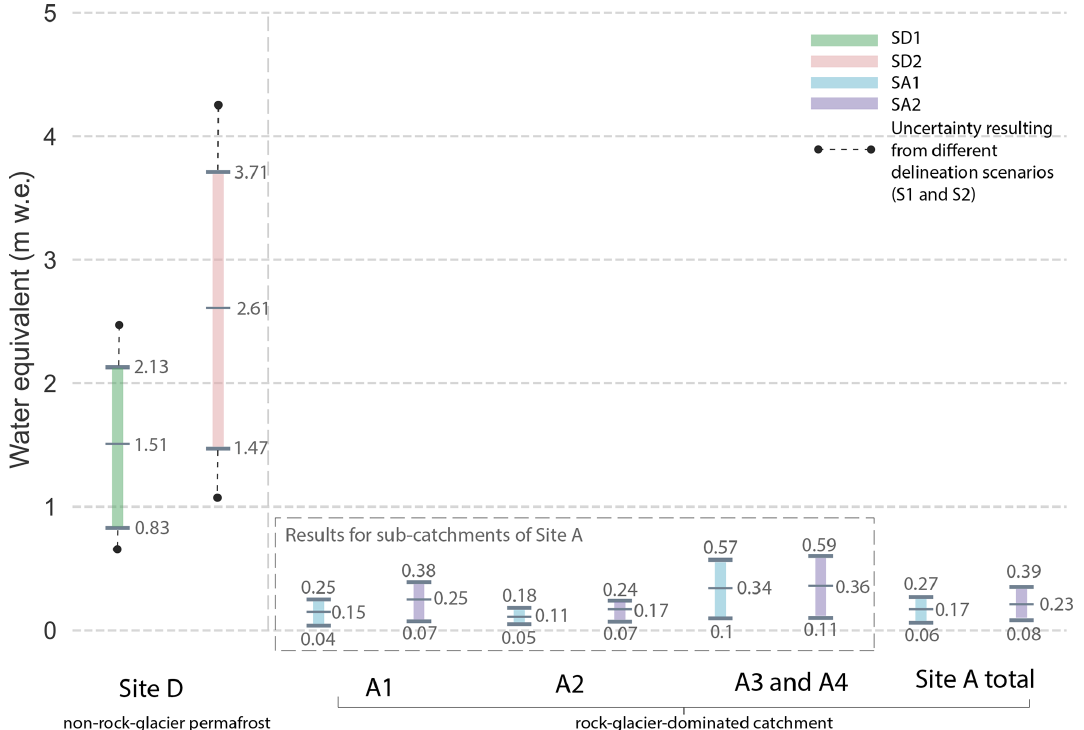
Figure 8. Calculated minimum, mean, and maximum water equivalents (mw.e.) for the different scenarios (SD1–SA2), as well as for rock glaciers and talus slopes, at Site A only. For SD1 and SD2, the black bars indicate the uncertainty resulting from using different delineation scenarios for the upscaling classes (see